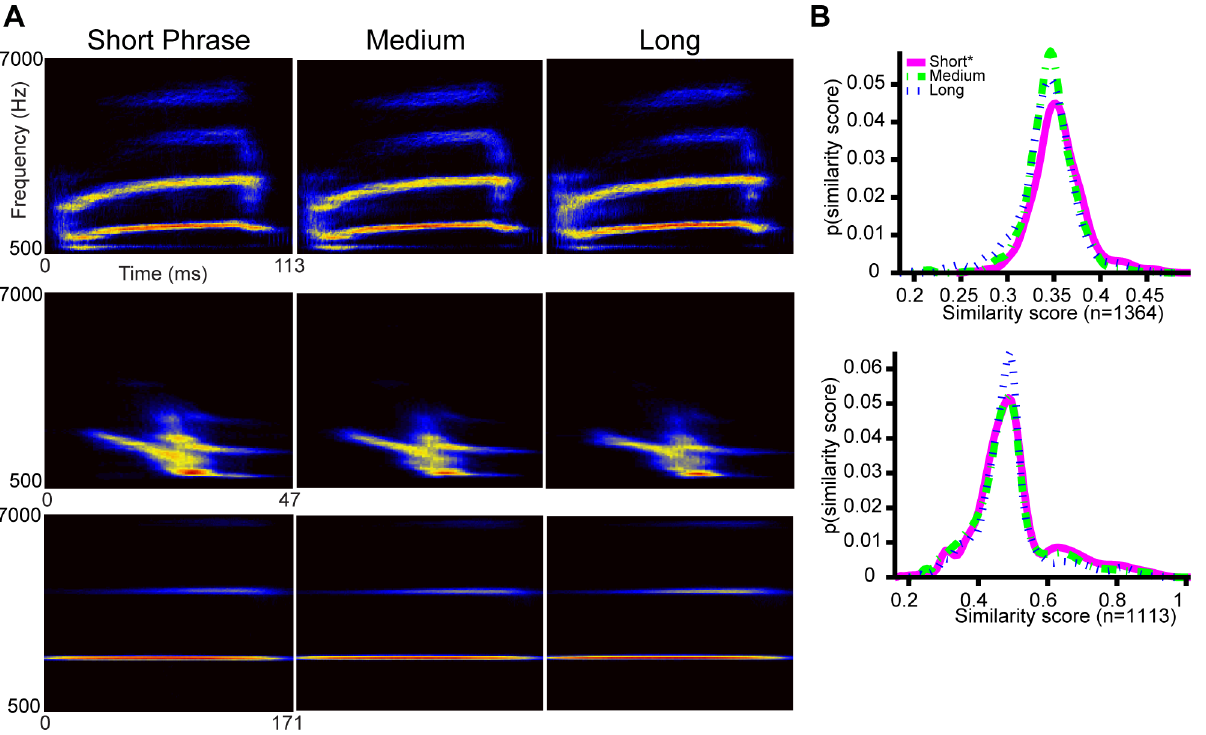
Figure 3. Renditions of the same syllable in short, medium and long phrases are highly similar. A, Spectral density images were computed for matching syllables in phrases of different relative durations. The images were taken from 2 different birds. B, Similarity scores reflect the acoustic similarity between individual sounds and the spectral density image for a group of sounds. Here, we computed the similarity scores of the same syllable extracted from short, medium and long phrases with respect to the spectral density image for syllables extracted from short phrases. These distributions show that phrase duration does not affect the acoustic form. Top: similarity scores for the syllable type from the middle row in Fig. 3a . Bottom: similarity scores for the syllable type from the third row in Fig. 3a . Summary statistics for these distributions are given in Table S2 . syllable transitions over 4–5 intervening phrases, spanning a time-scale of up to ten seconds.